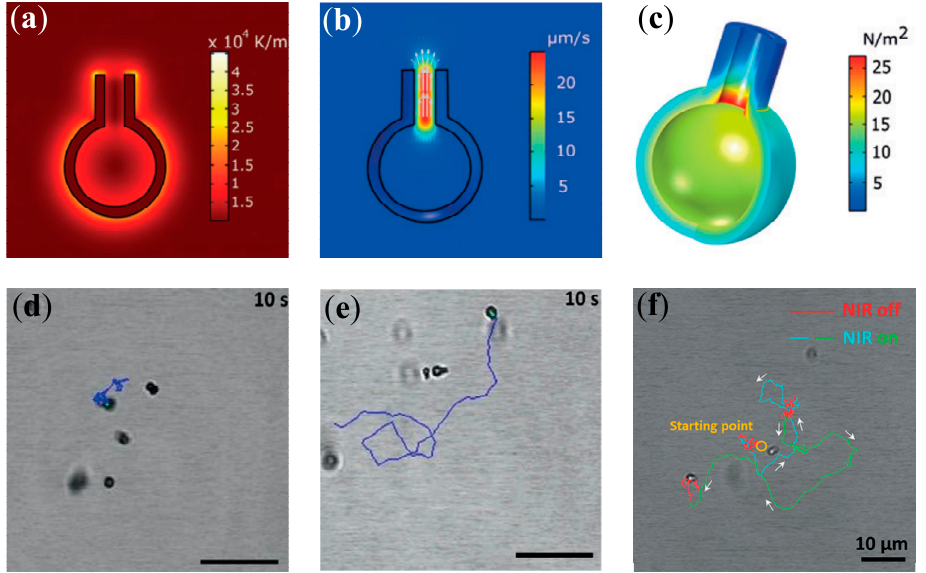
Figure 3. ( a ) The temperature gradient around carbonaceous nanobottle. ( b ) The fluid velocity dis- tribution of heated fluid in nanobottle. ( c ) Pressure distribution caused by the change in internal pressure. At ( d ) 0 Wcm − 2 and ( e ) 1.36 Wcm − 2 , the trajectories diagram of carbonaceous nanobottle motor in near-infrared light are shown. ( f ) The image of carbonaceous nanobottle motor motion, through the switching on/off of the near-infrared light , white arrows are the direction of directional motion. The scale bar is 10 μ m. Reprinted with permission from Ref. [36]. Copyright 2018, copyright Wiley-VCH GmbH.